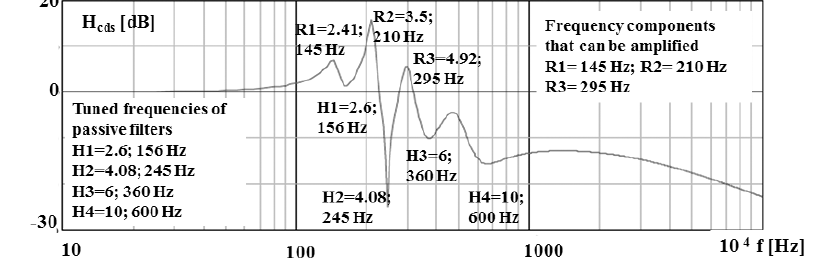
Figure 5. Frequency response of the filtering system.